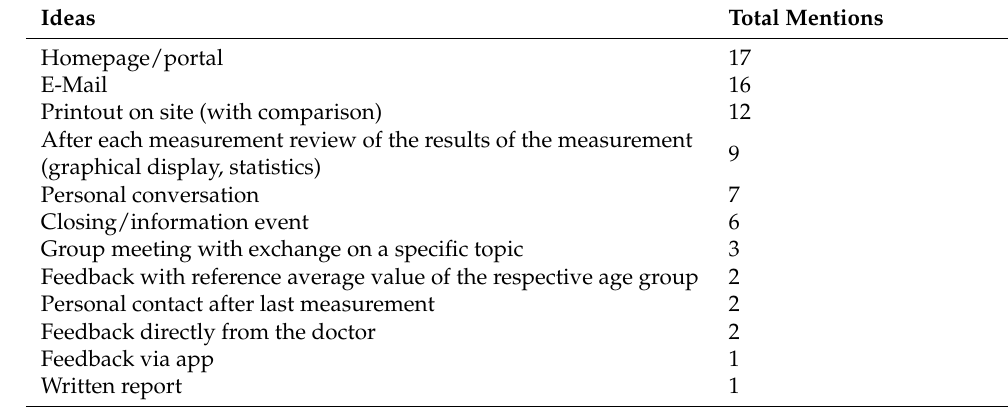
Table 5. Ideas for